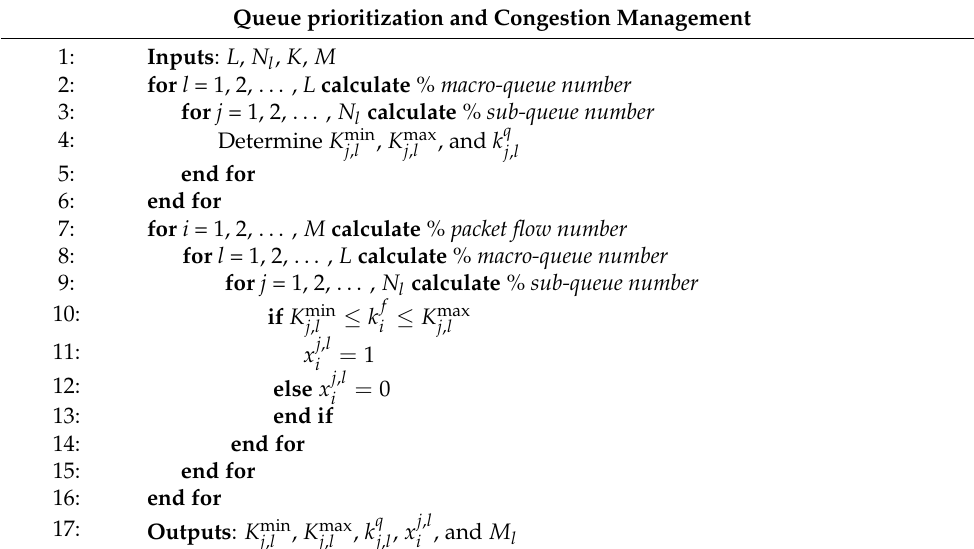
Table 2. Queue prioritization and congestion management problem-solving